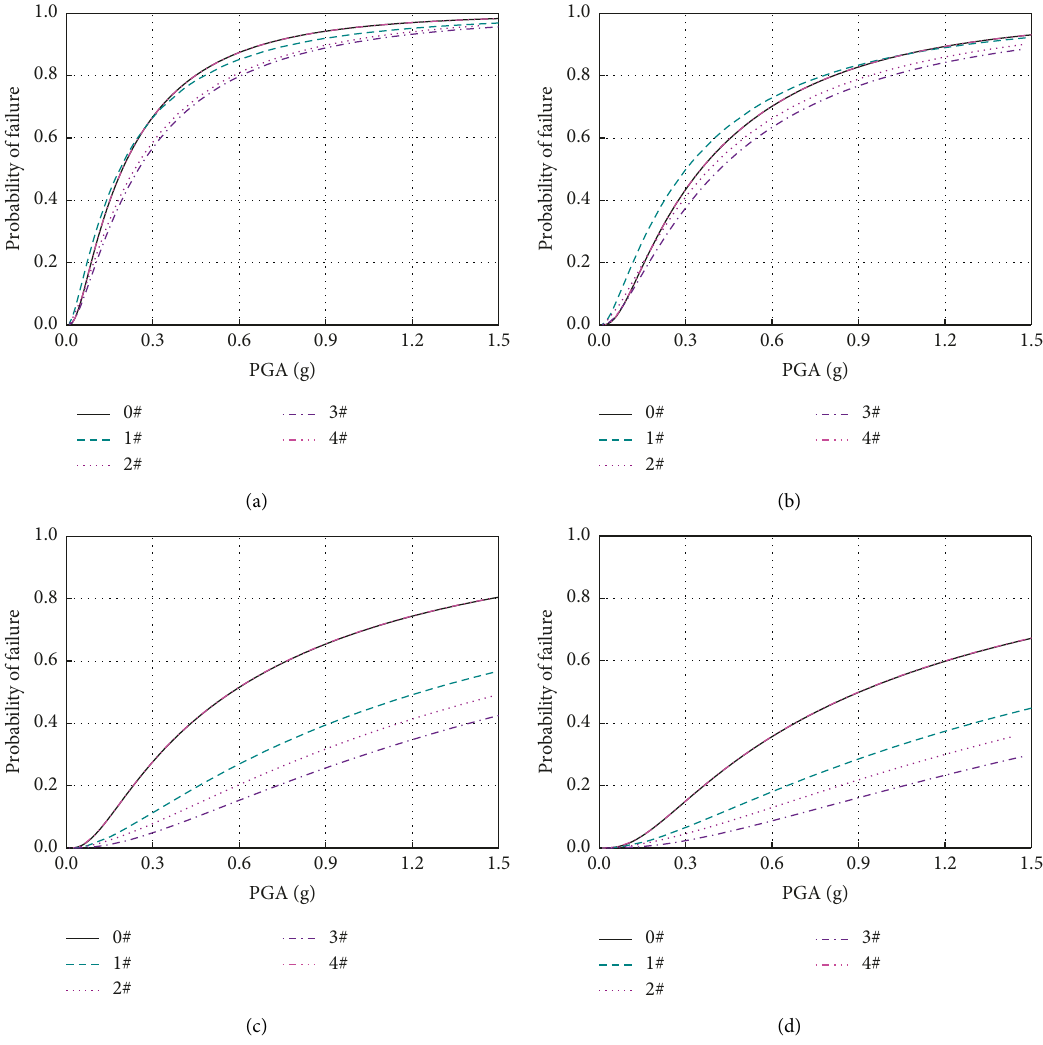
Figure 9: Seismic vulnerability curves of combined components: (a) slight damage; (b) moderate damage; (c) serious damage; and (d) complete